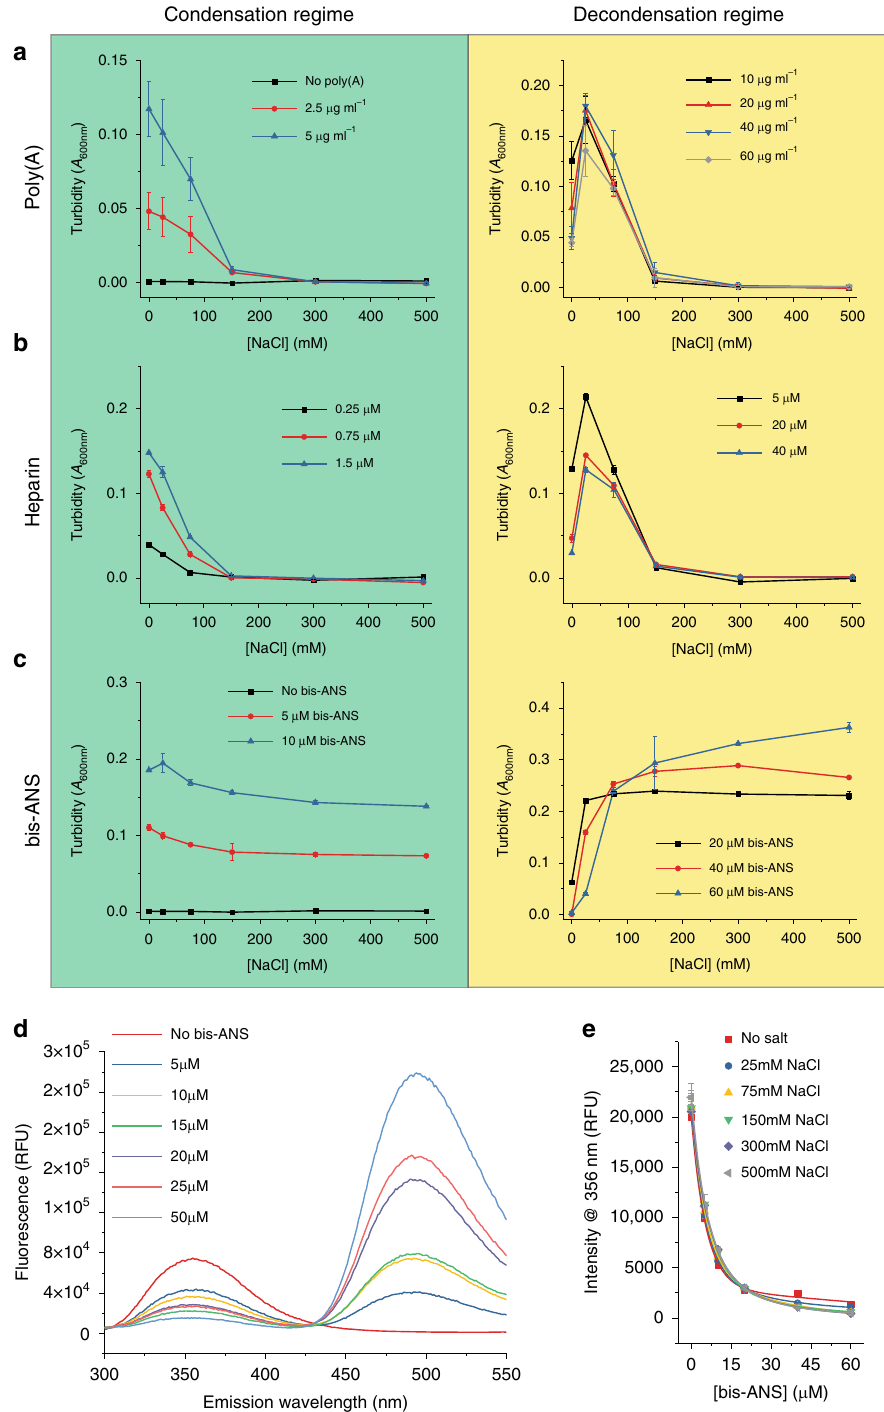
Fig. 3 Role of charge-based interactions in various TDP-43 LLPS systems. a – c Turbidity of TDP-43 LCD (5 μ M) as a function of salt concentration in the presence of varying cofactor concentrations, including a poly(A), b heparin, and c bis-ANS. Individual columns depict data for cofactor concentrations associated with the condensation regime (green) or decondensation regime (yellow) for biphasic curves as originally de fi ned in the absence of NaCl ( n ≥ 3 technical replicates). d Fluorescence spectra (280 nm excitation wavelength) for TDP-43 LCD (10 μ M) in the presence of varying concentrations of bis- ANS. e Fluorescence intensity at 356 nm for TDP-43 LCD as a function of bis-ANS concentration in the presence of varying concentrations of NaCl. All experiments depicted in this fi gure were performed in 20 mM potassium phosphate buffer, pH 6.0, using untagged protein at a concentration of 5 μ M ( n = 3 technical replicates). All data are presented as mean values ± standard